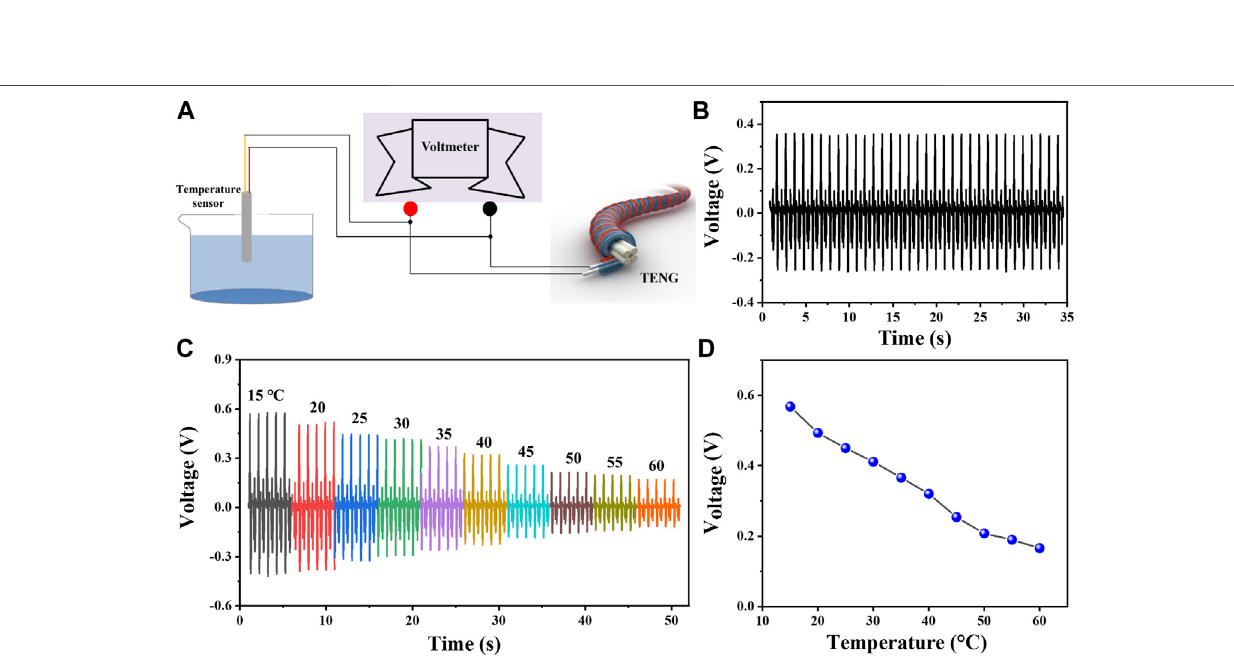
Frontiers in Bioengineering and Biotechnology |